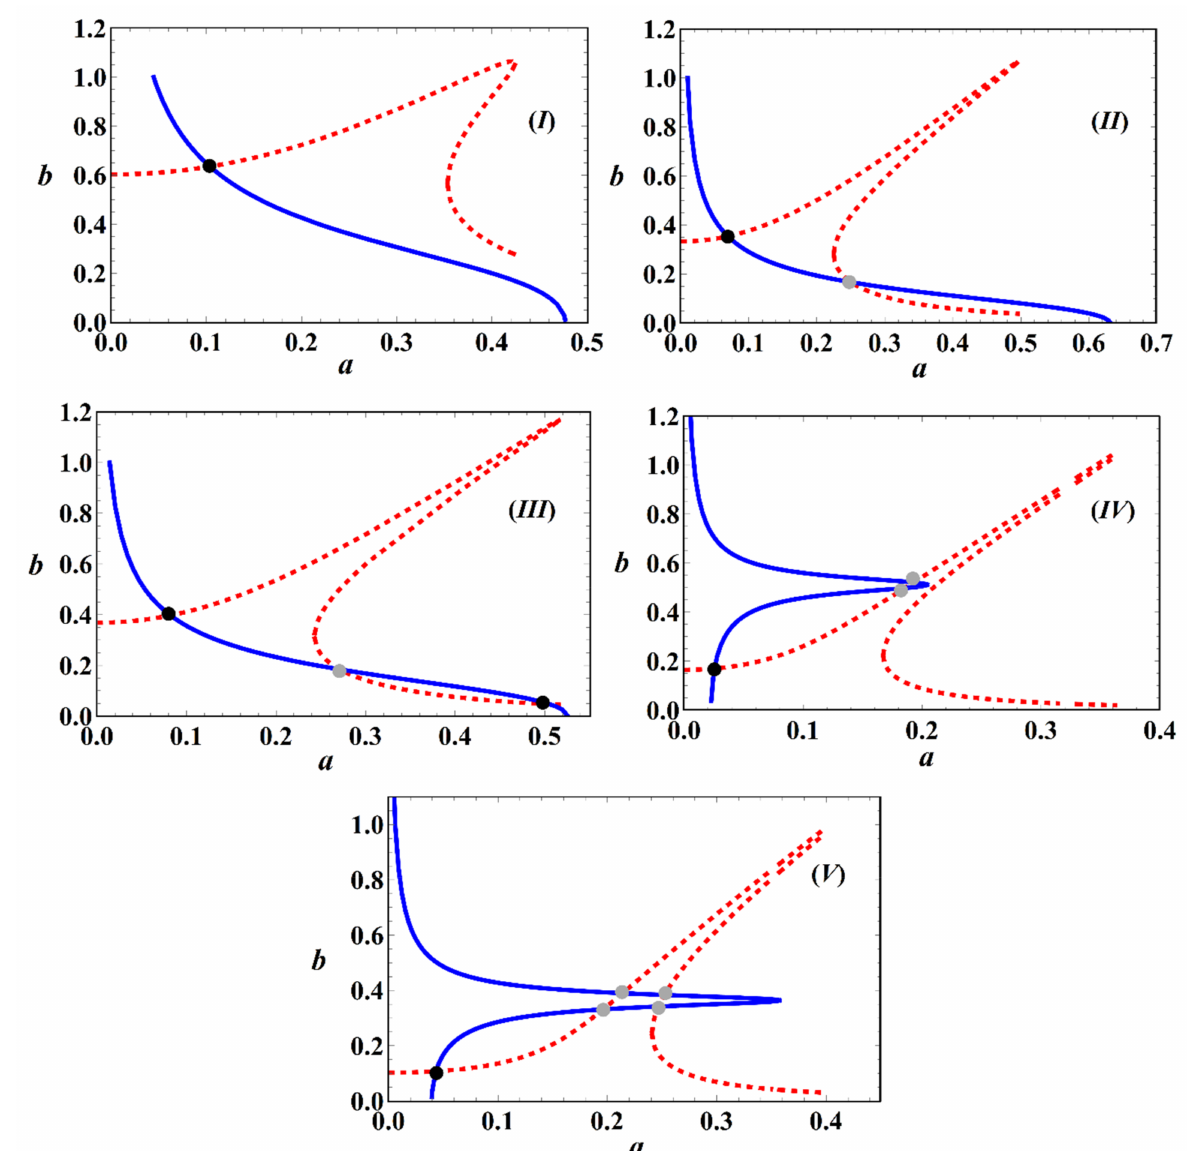
Figure 7. The steady-state solutions with ( I ) one fixed point when σ 1 = − 0.003, σ 2 = 0.003, l = 1 and m = 0.1, ( II ) two fixed points when σ 1 = − 0.003, σ 2 = 0.003, l = 1 and m = 0.2, ( III ) three fixed points at σ 1 = − 0.003, σ 2 = 0.003, l = 1.2 and m = 0.2, ( IV ) three fixed points at σ 1 = 0.009, σ 2 = 0.002, l = 2.45 and m = 0.1, and ( V ) five fixed points at σ 1 = 0.009, σ 2 = 0.009, l = 1.4 and m =